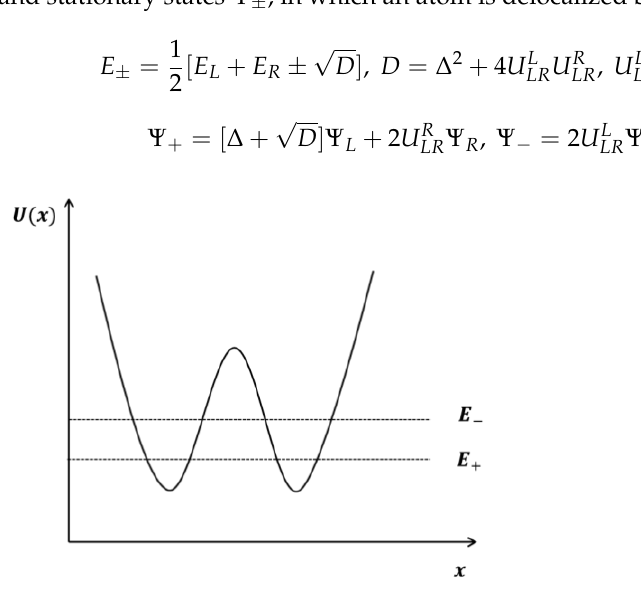
Figure 2. Ground state for a symmetric ( Δ = 0 ) double-well potential U (x). Quantum tunneling removes the initial degeneracy of the levels. E + —energy eigenvalue for a symmetric wave function Ψ + ; E − —energy eigenvalue for an antisymmetric wave function